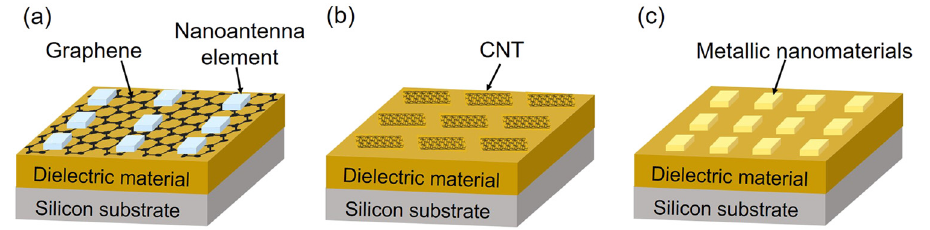
Figure 3: Schematic diagram of ( a ) graphene - based nanoantennas, ( b ) CNT - based nanoantennas, and ( c ) metallic nanomaterial - based